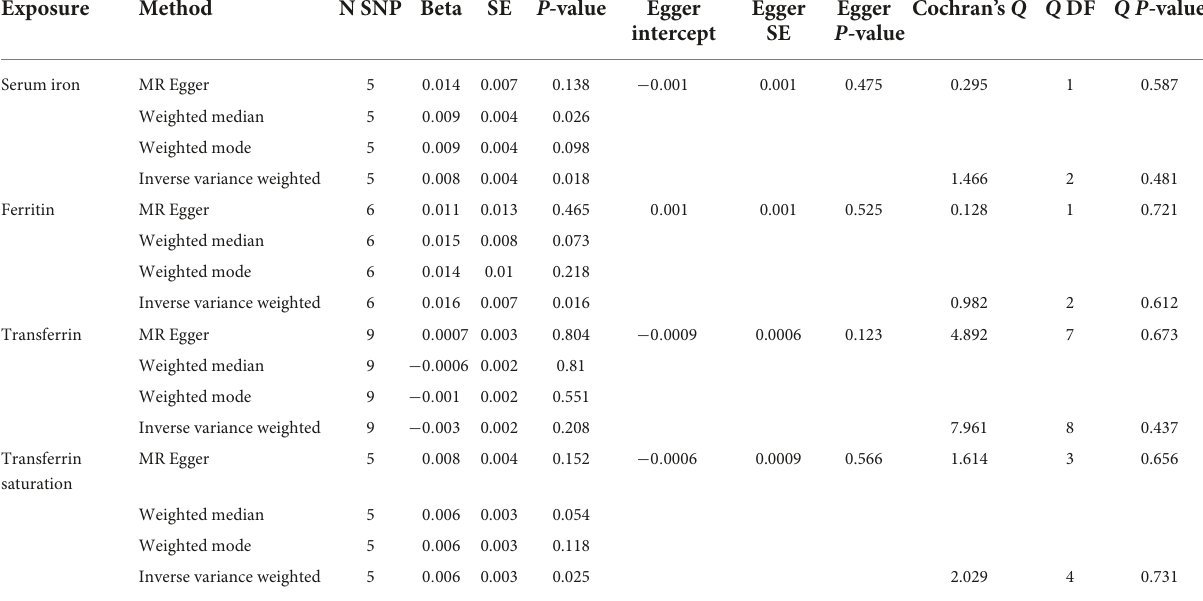
TABLE 3 Associations between genetically instrumented systemic iron status and back pain using the separately selected SNPs associated with all four iron status biomarkers.